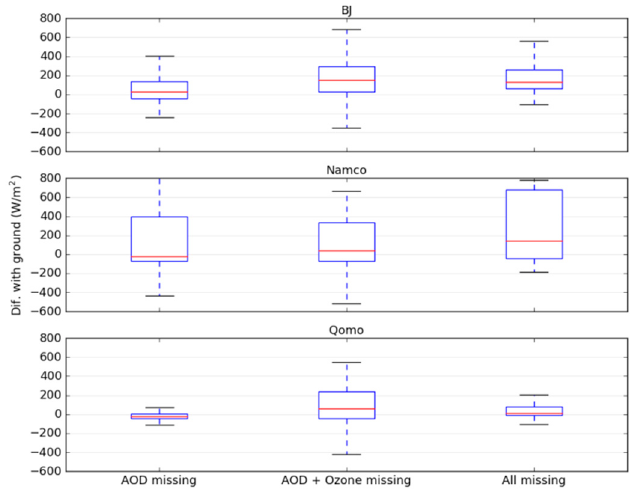
Figure 9. Comparison of the differences in W·m − 2 between estimated and measured instantaneous incoming fluxes at BJ, NamCo, and Qomolangma (Qomo) according to the input missing during the computation.